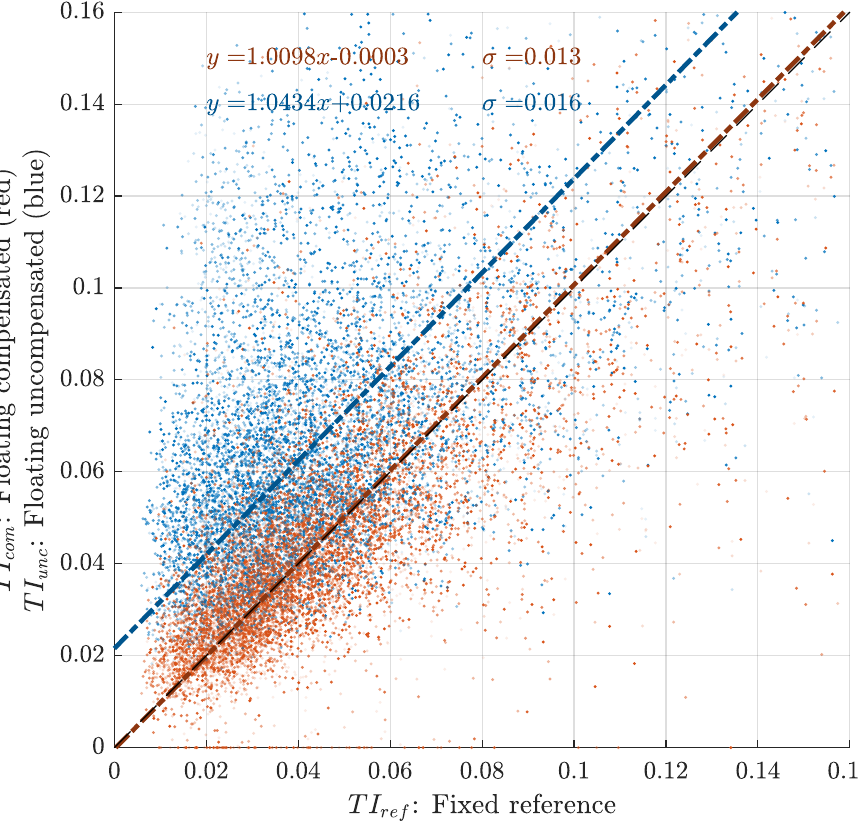
Figure 12. Scatter plot of turbulence intensities from the floating lidar uncompensated (blue) and compensated (red) vs. from the land-based reference lidar. Deming regression lines are given in corresponding colors. The equations of the regression lines and their standard deviations are listed. The black dashed line is the y = x line. Some datapoints lie outside the plotted